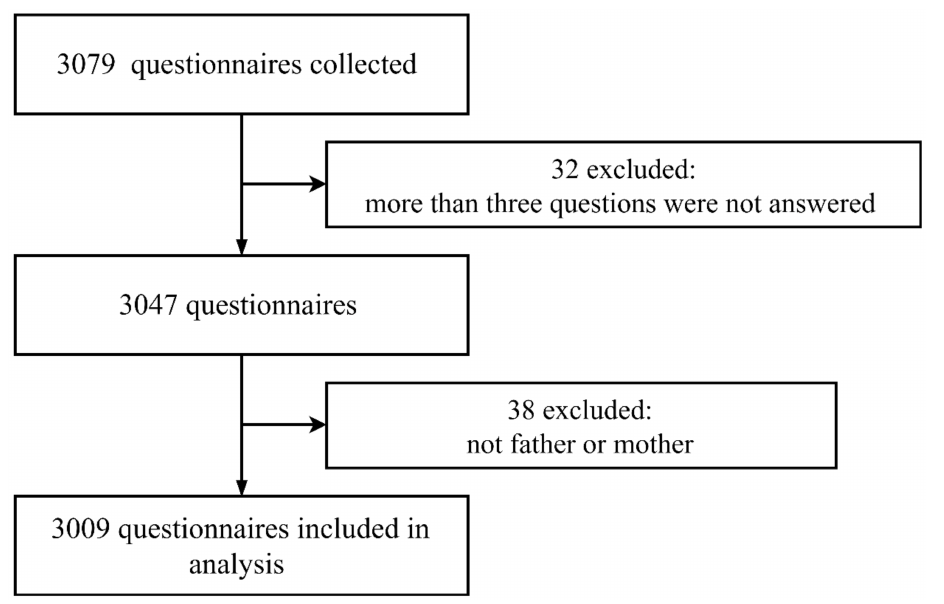
Figure 1. Flow chart for parent questionnaires. Table 2. Participants’ sociodemographic